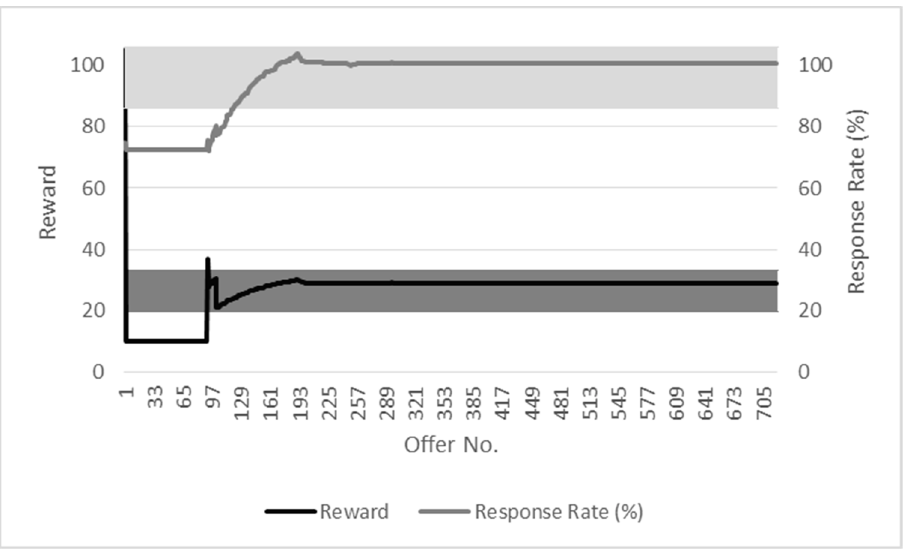
Figure 3. Reward adaptiveness: high response environment.